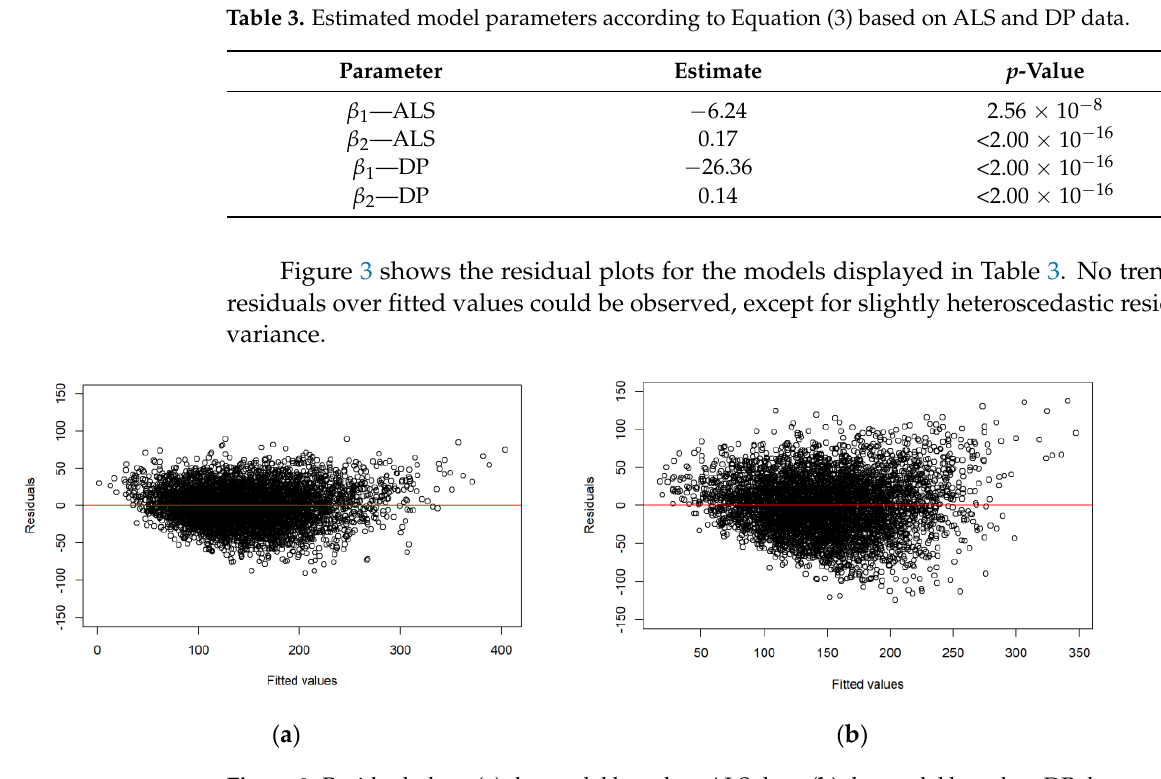
Figure 3. Residual plots: ( a ) the model based on ALS data; ( b ) the model based on DP data.